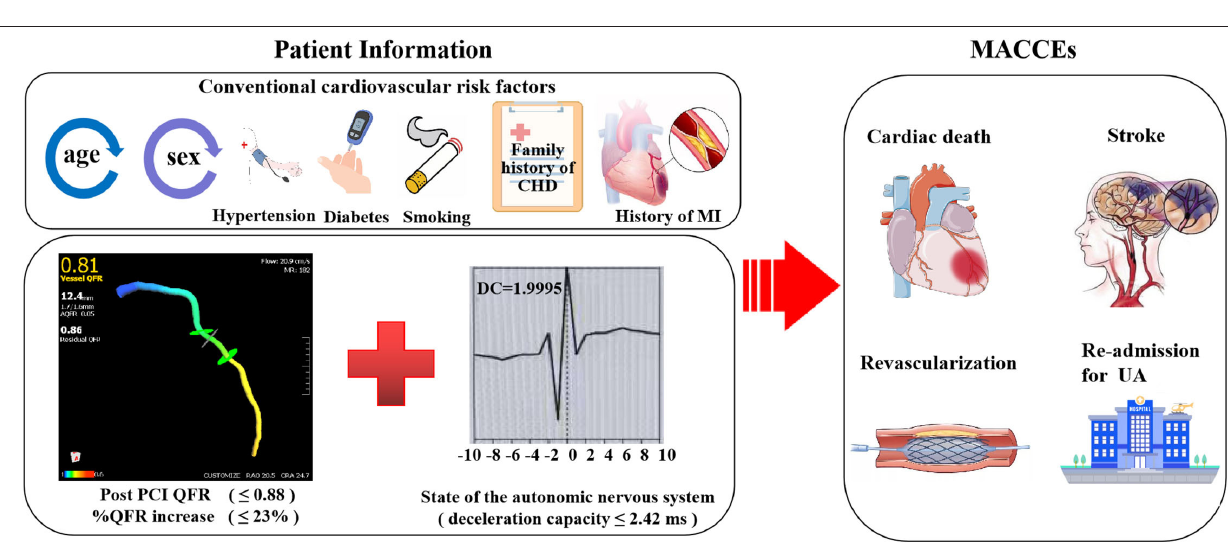
FIGURE 8 | Combined efficacies of post-PCI QFR, %QFR increase and deceleration capacity for risk stratification in patients with